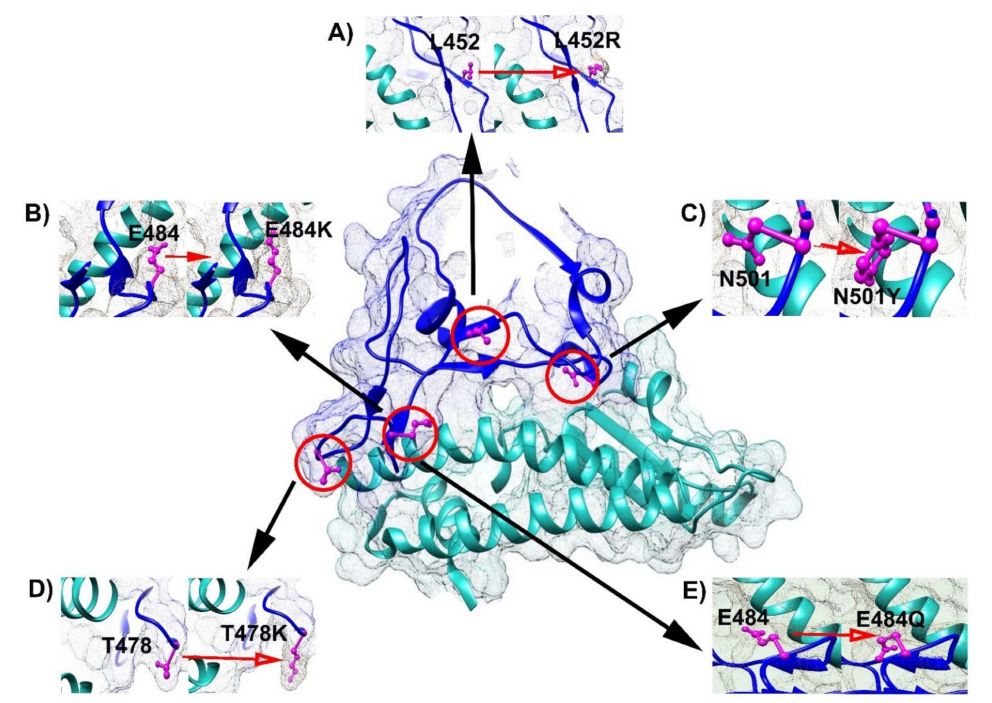
Figure 1. Locations of single mutated RBD and ACE2. The center shows the RBD–ACE2 complex. Blue color: RBD; grey color: ACE2. ( A ) L452 and L452R; ( B ) E484 and E484K; ( C ) N501 and N501Y; ( D ) T478 and T478K; ( E ) E484 and E484Q. Magenta color: amino acid